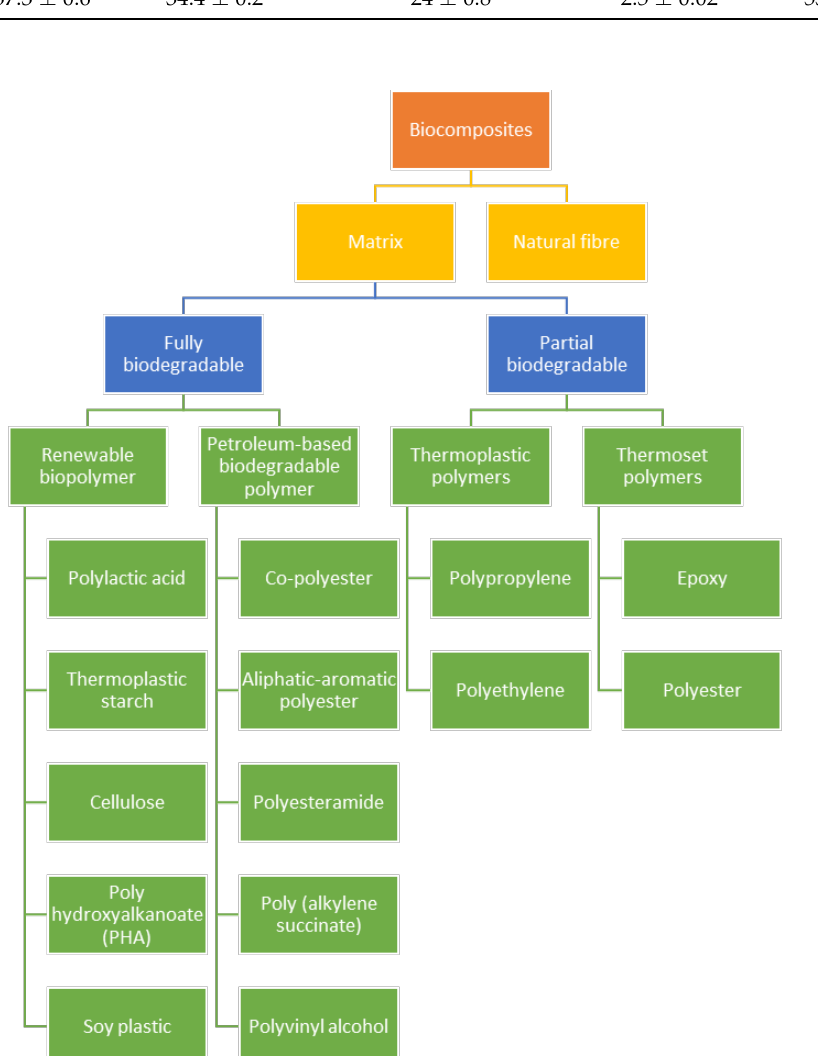
Figure 1. Classification of biocomposites. Adapted with copyright permission from Mohanty et al. [67]. Besides this, the surface structure of the natural fibre plays a vital role in the adhesion behaviour of the matrix polymer and the fibres. The higher and stronger the fibres and matrix adhesion, the better the natural fibres’ mechanical properties. The composite intensity depends on the various level of the fibres in use and is approximately equal to its matrix binding